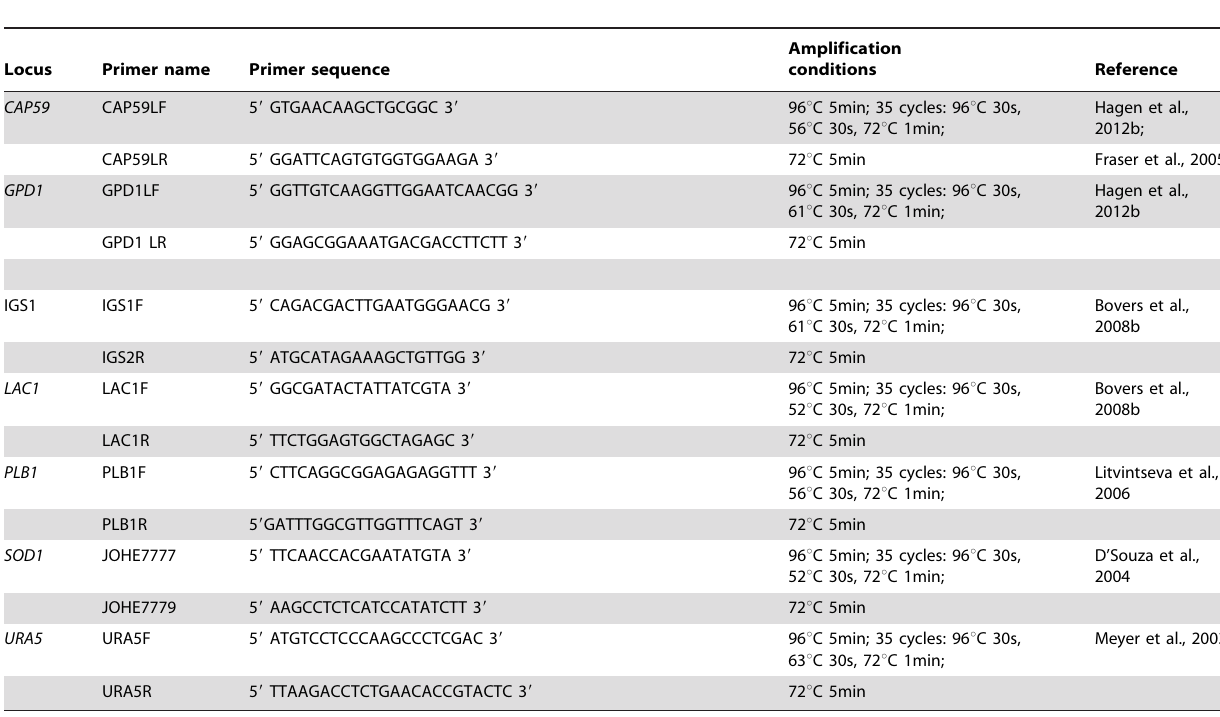
Table 1. Primers used for MLST analysis of Asian C . neoformans var. grubii isolates.